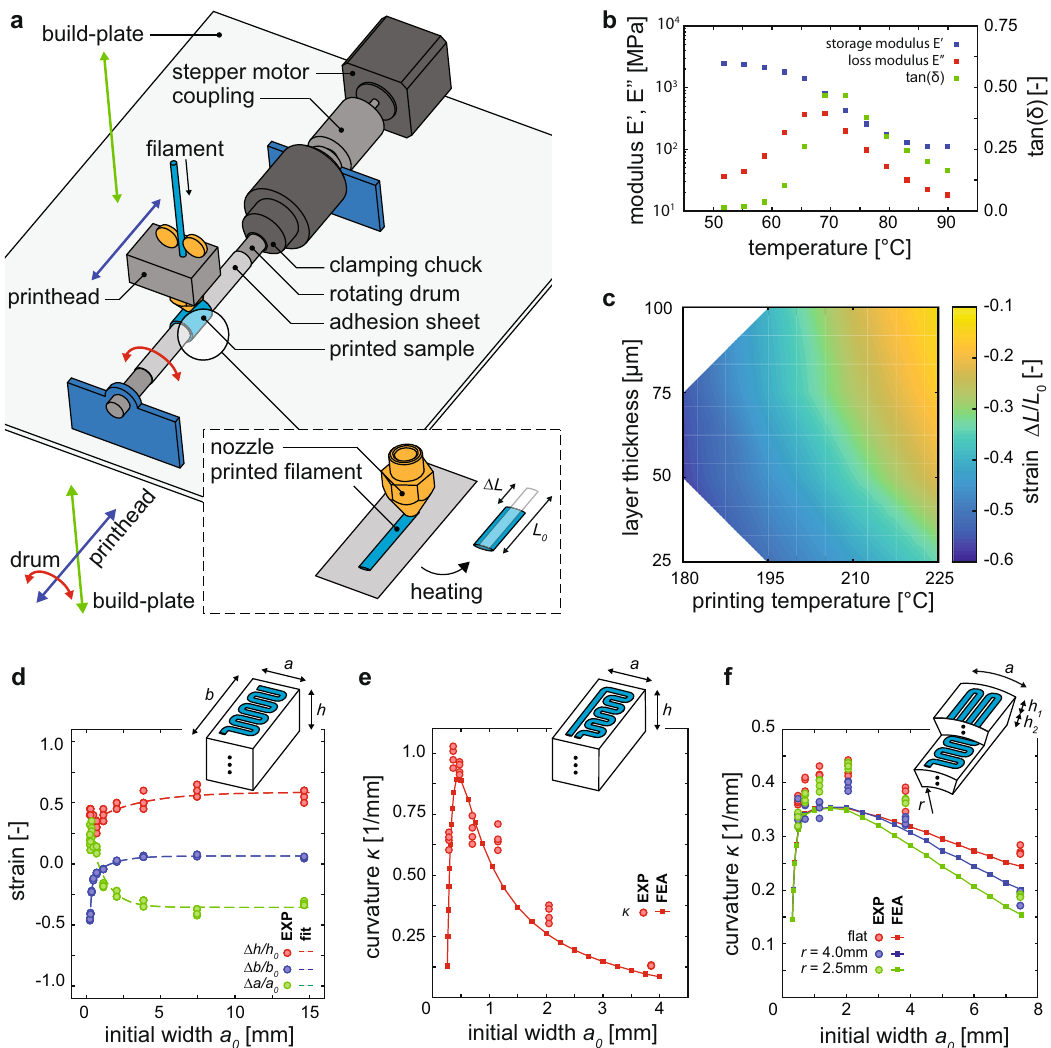
Fig. 1 4D printing concept. a A schematic illustration of the methodology used for the fabrication of curved shape-shifting specimens. b The storage modulus, loss modulus, and tan( δ ) of the molded PLA specimens for a frequency of 10 Hz. c The effects of the layer thickness and printing temperature on the longitudinal shrinkage of the printed fi laments. d – f The deformation characteristics of the basic building blocks as a function of the initial width. See Supplementary Video